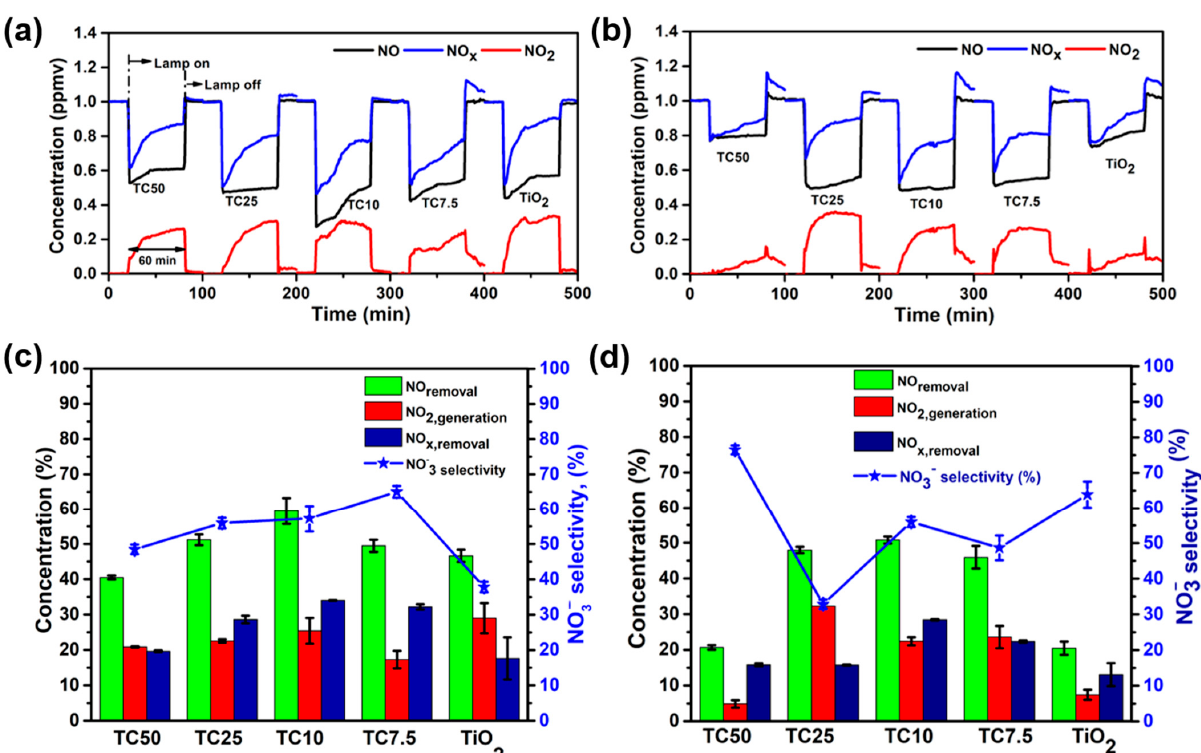
Figure 7. Time profiles of NO, NO 2, and NO x under ( a ) UV and ( b ) visible light irradiation; the profile of estimated NO removal , NO 2, generation , NO x, removal, and NO 3 − selectivity of TiO 2 and N-doped TiO 2 with different N contents under ( c ) UV and ( d ) visible light irradiation, respectively.